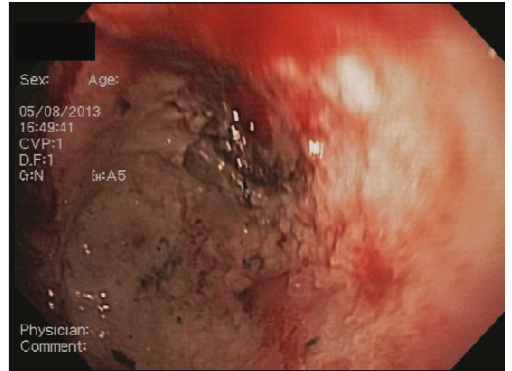
Figure 2: After injection of epinephrine and electrocoagulation with BICAP